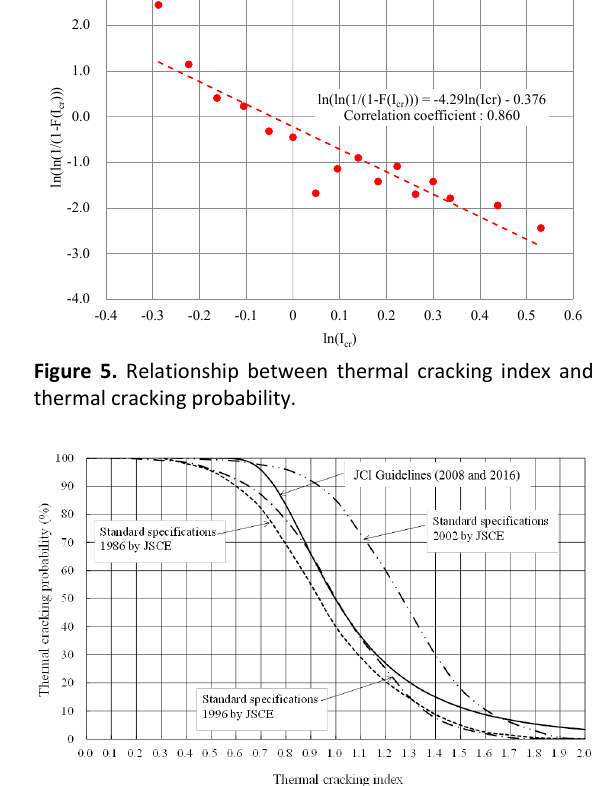
Figure 6. Thermal cracking